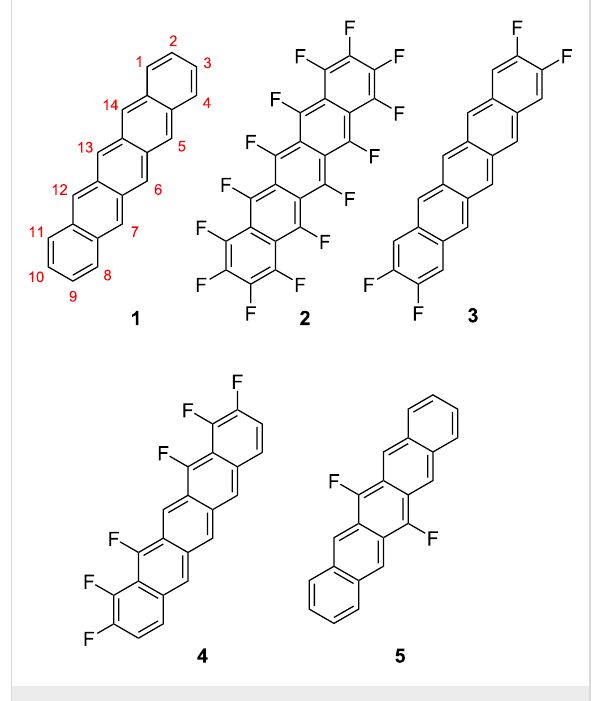
Figure 1: Structures of pentacene and fluorinated pentacenes.